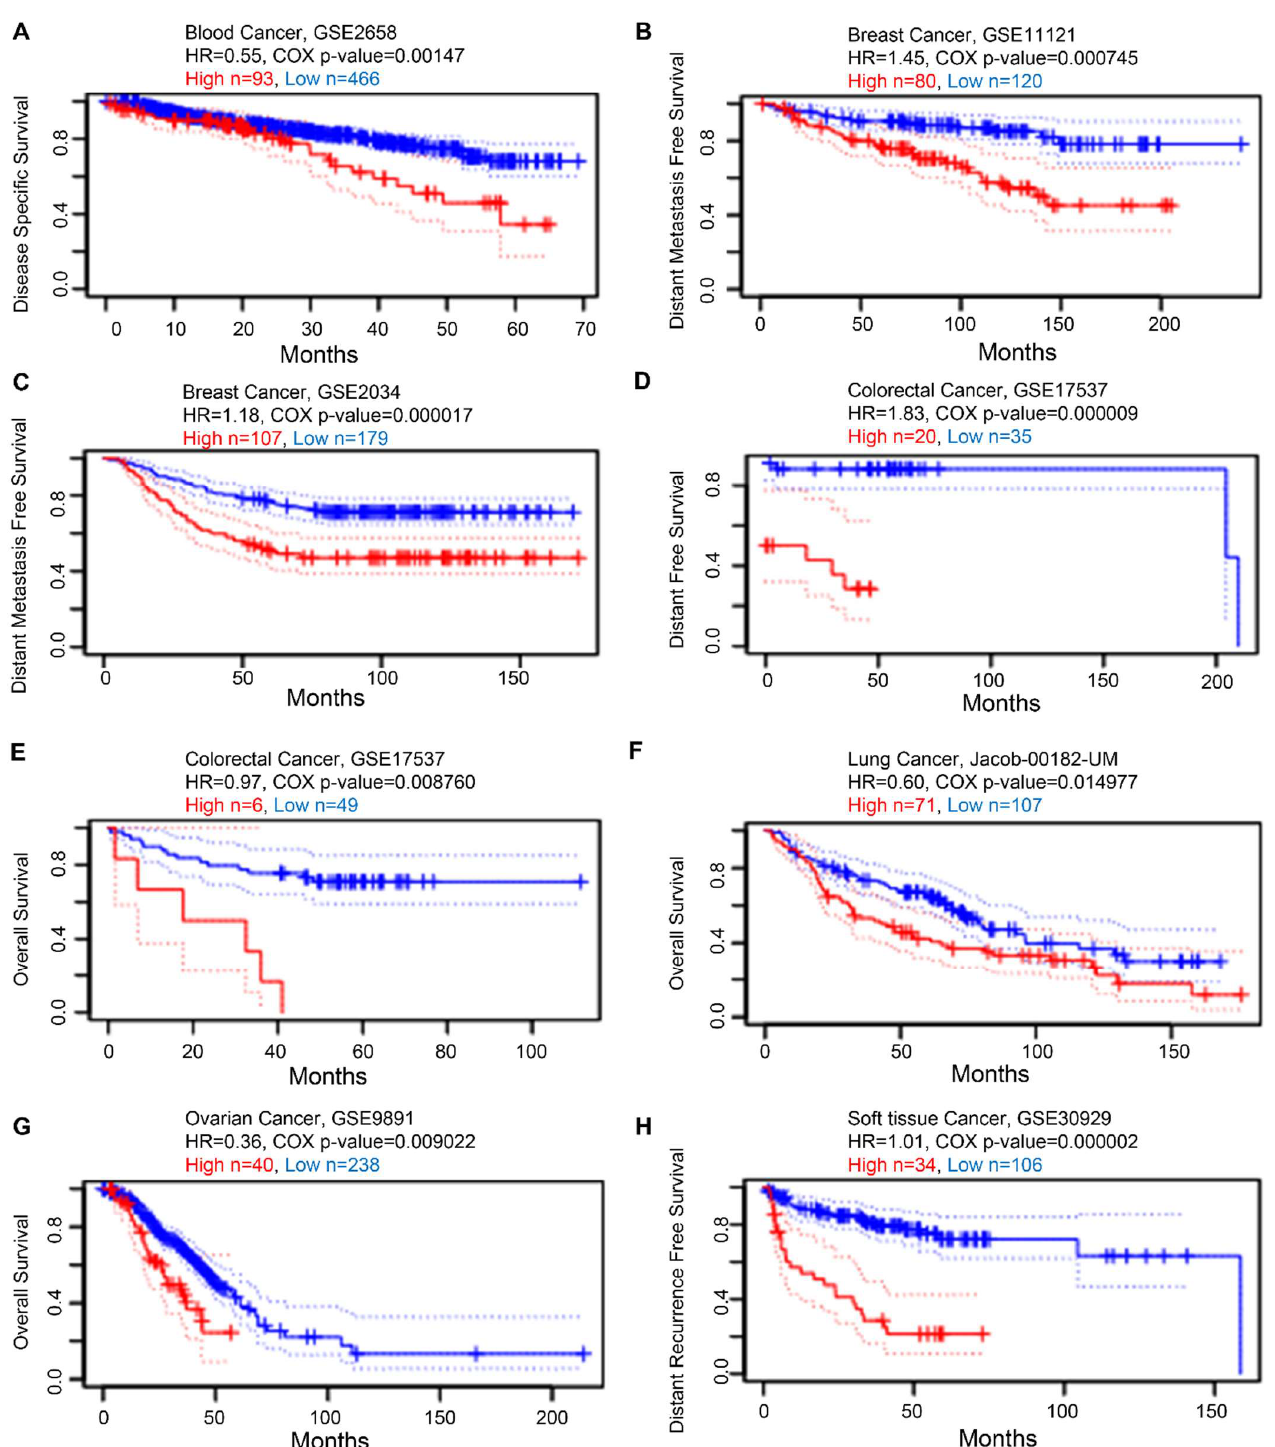
Figure 6. Kaplan–Meier survival curves comparing high and low expression in multiple cancer types from PrognoScan. ( A ) Disease-specific survival of blood cancer patients. ( B , C ) Distant metastasis-free survival of breast cancer patients. ( D , E ) Distant-free survival ( D ) and overall survival ( E ) of colorectal cancer patients. ( F ) Overall survival of lung cancer patients. ( G ) Overall survival of ovarian cancer patients. ( H ) Distant recurrence-free survival of soft tissue cancer patients. A p -value < 0.05 was considered a significant threshold.